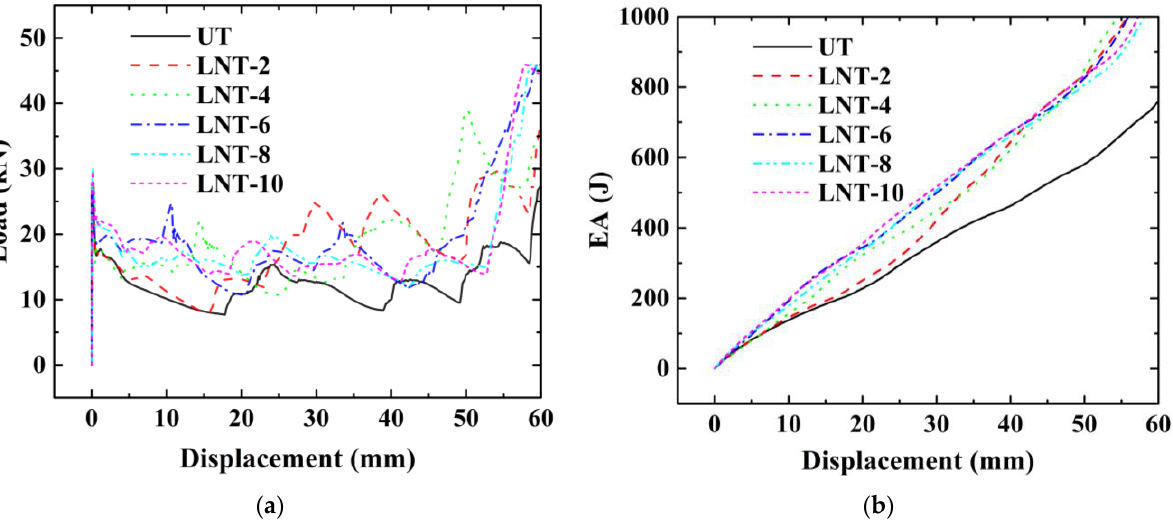
Figure 13. The effect of stripe number for tubes with even circumferential stripes: ( a ) load–displacement relations; ( b ) energy–displacement relations. Table 8. Effect of stripes on energy absorption properties.